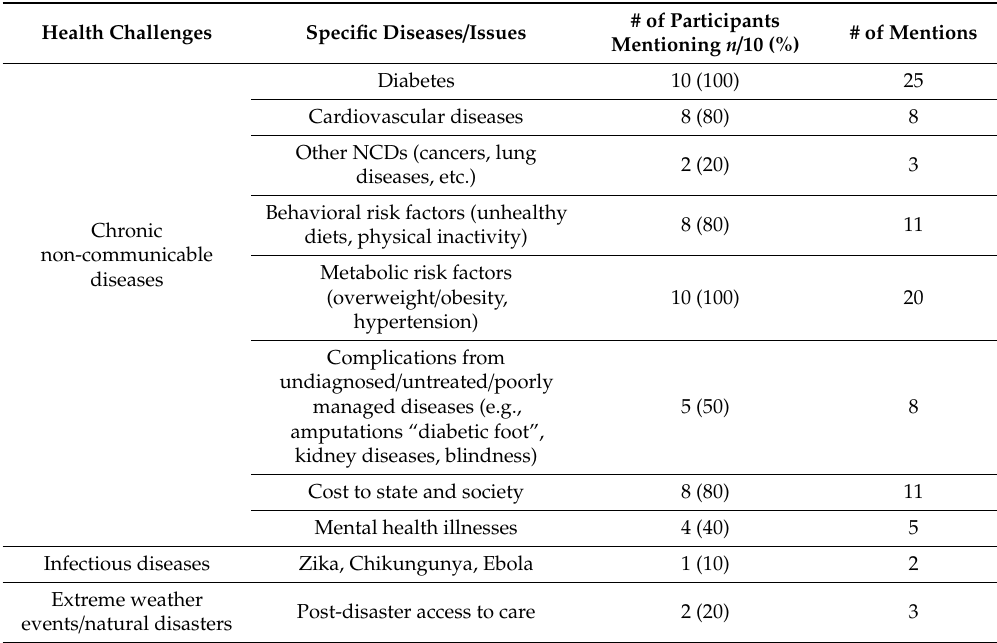
Table 2. Key informant views on health challenges in